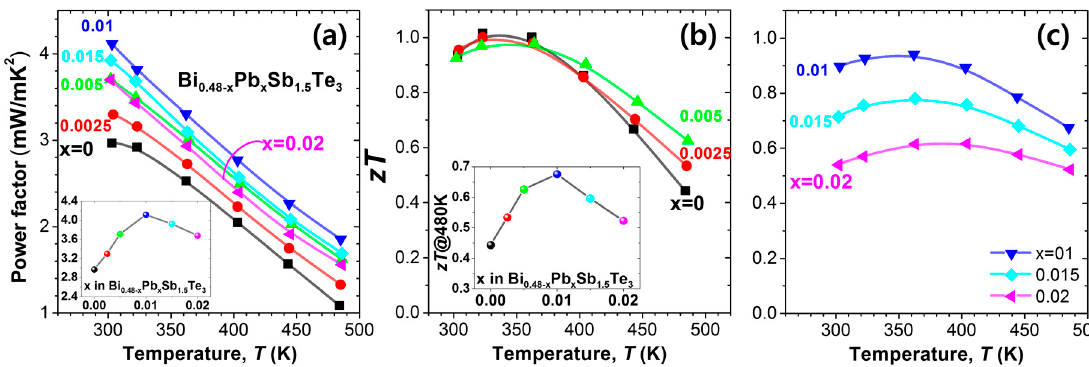
Figure 3. ( a ) Temperature dependence of power factor ( σ S 2 ) for Bi 0.48- x Pb x Sb 1.52 Te 3 ( x = 0, 0.0025, 0.005, 0.01, 0.015, and 0.02). Inset shows the power factor value at 300 K for the samples; ( b , c ) Temperature dependence of a dimensionless figure of merit, zT , for Bi 0.48- x Pb x Sb 1.52 Te 3 for ( b ) x = 0, 0.0025, and 0.005 and ( c ) x = 0.01, 0.015, and 0.02. Inset in ( b ) shows the zT value at 480 K. The power factor and zT data are taken from [9].